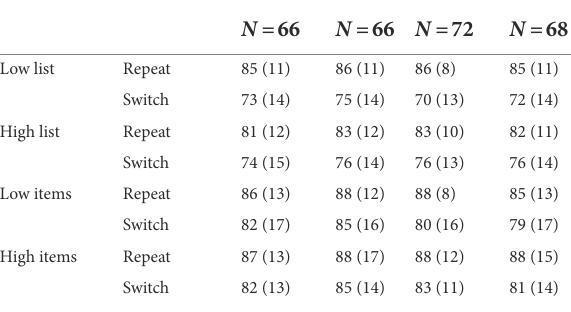
TABLE 4 Mean accuracy (%) with standard deviations in Experiment 1 as a function of background valence, switch probability, and transition separately in males and